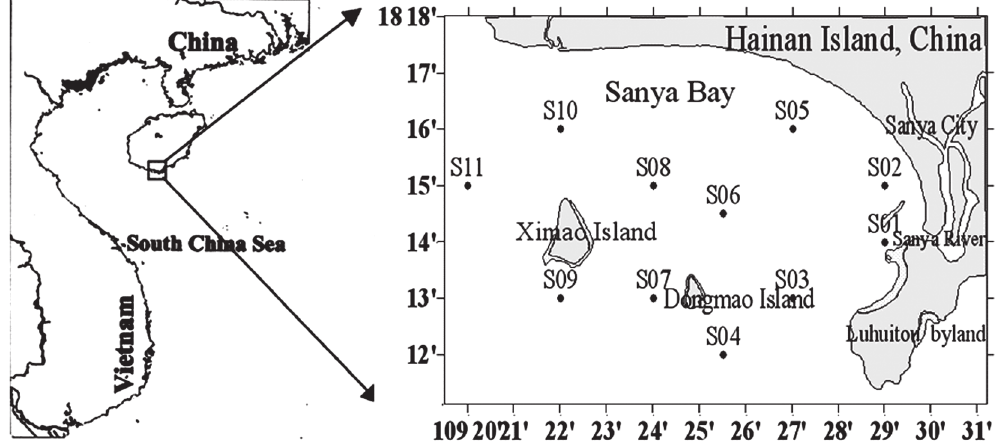
Fig . 1. – Location of sampling sites and research stations in sanya